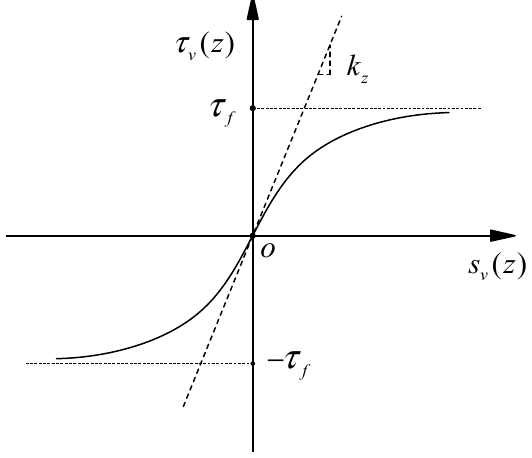
Figure 1. Pile–soil interface model of expansive soil after immersion.